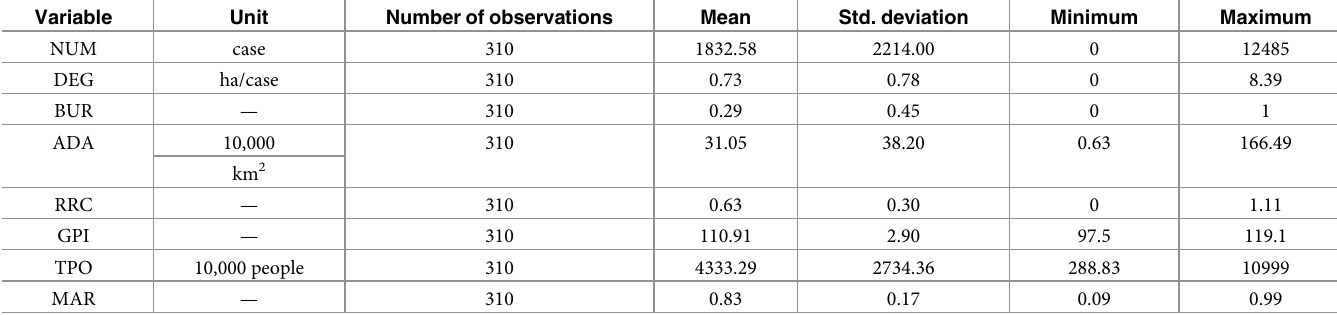
Table 2. Descriptive statistics of each variable listed in the